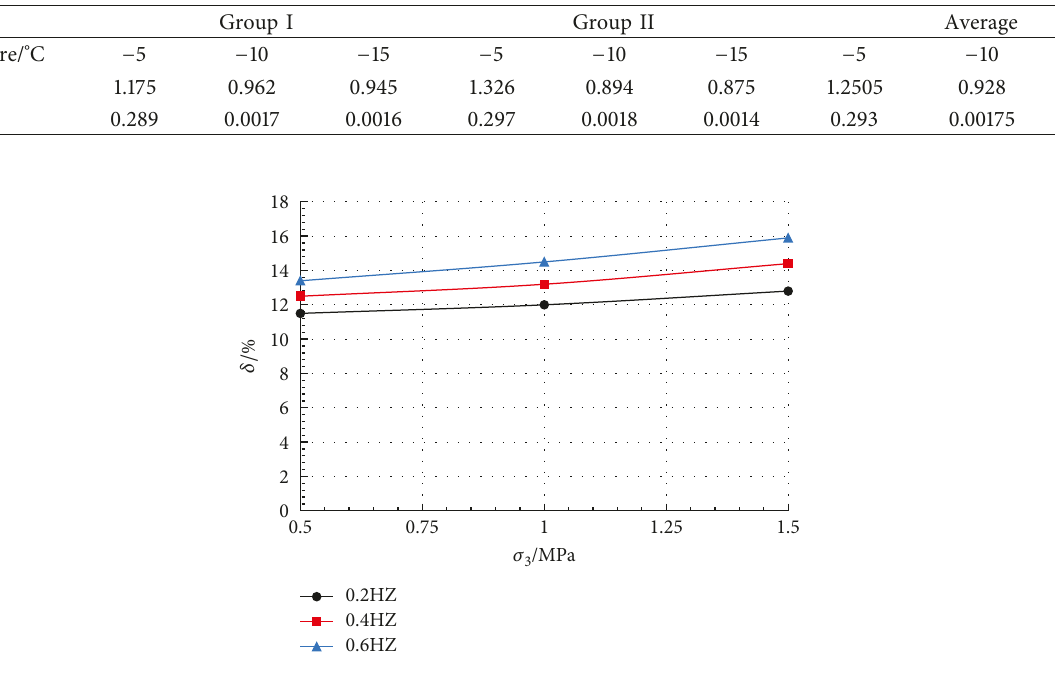
Figure 9: Relation between dynamic damping ratio and confining